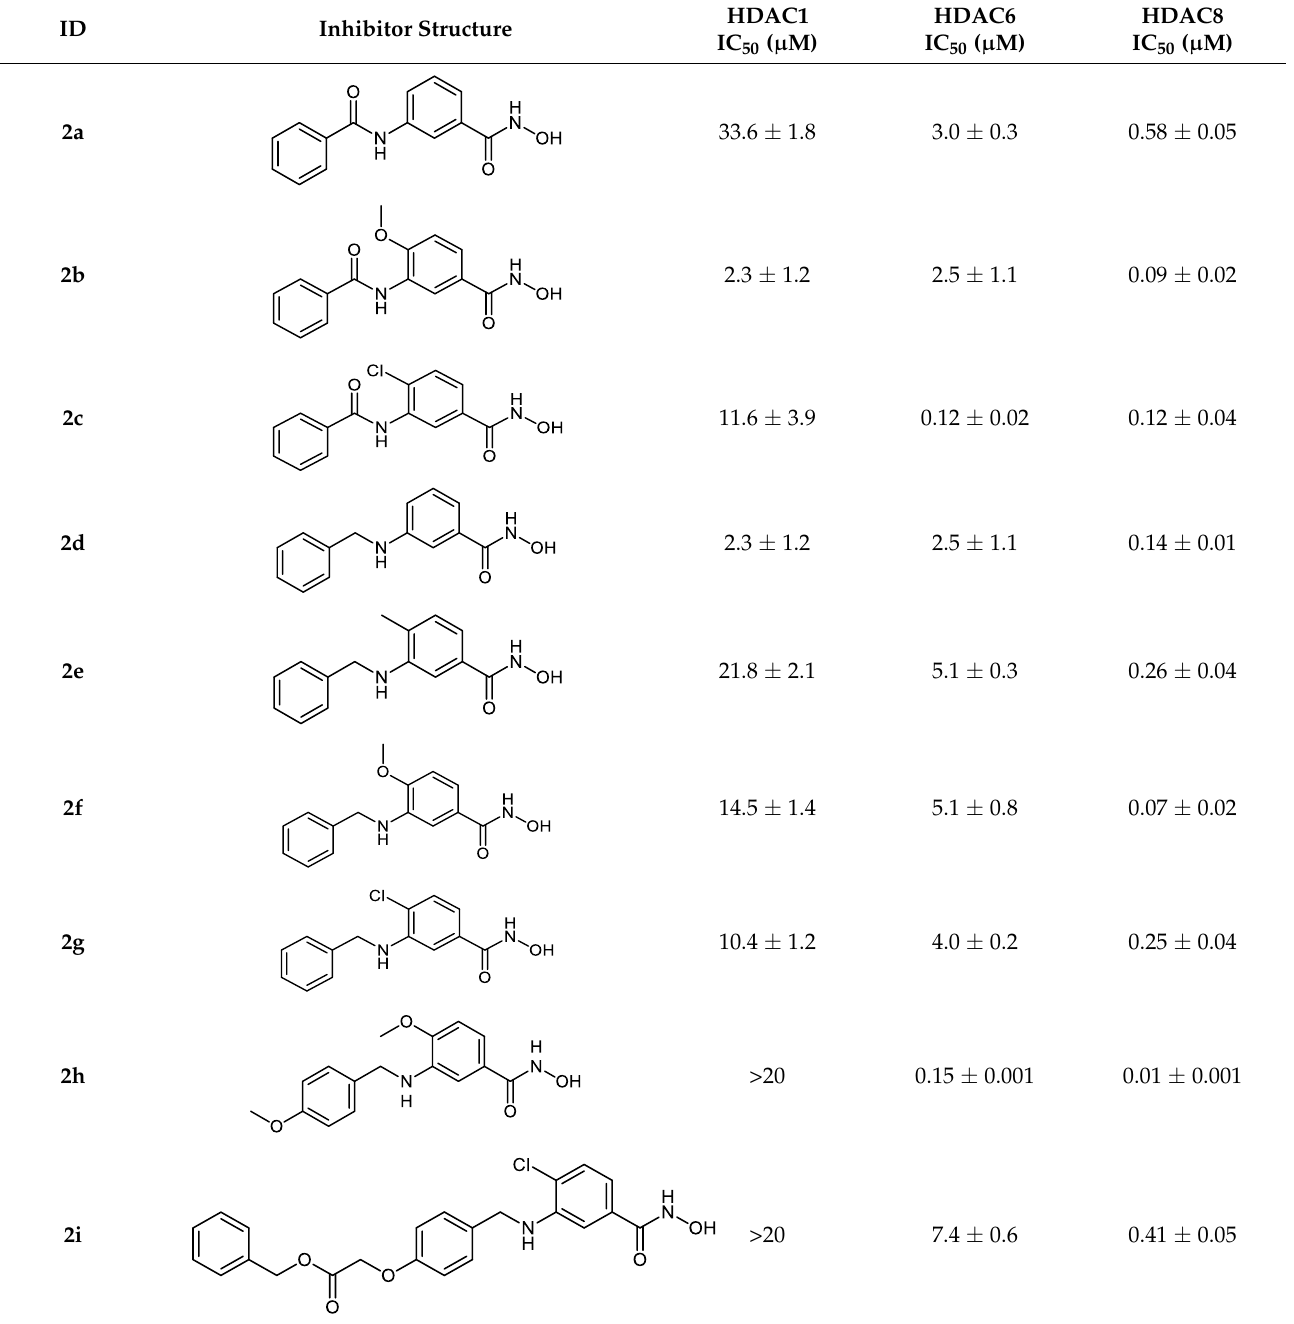
Table 2. IC 50 values for benzhydroxamate-based HADC inhibitors underlying PROTAC